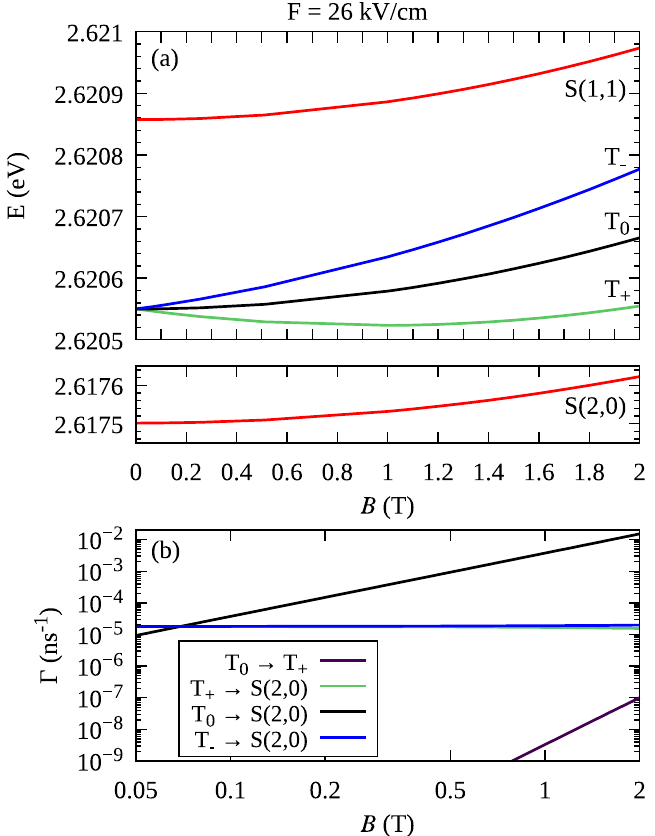
0 K ( b ) as a function of axial =